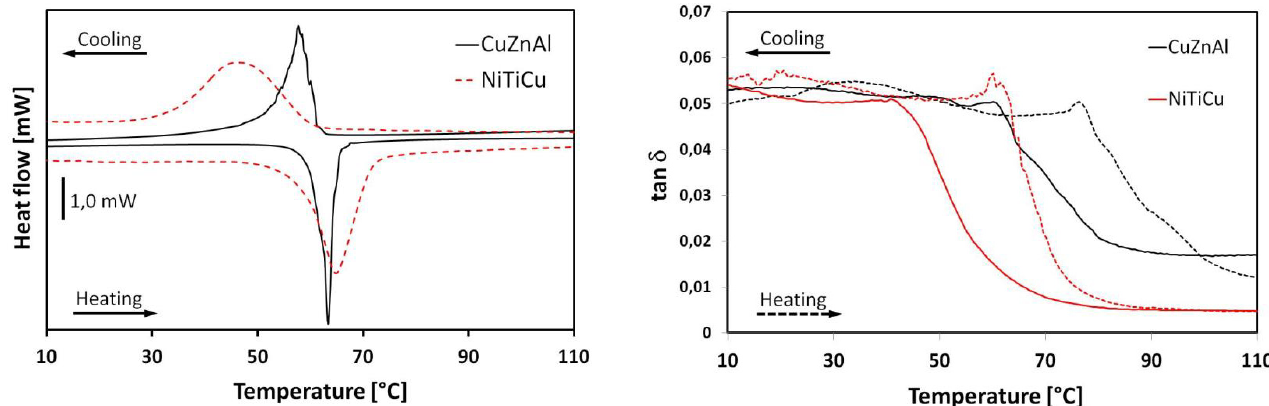
Figure 5: tan δ vs. temperature. DMA analysis: heating rate 1°C/min, frequency 10 Hz, strain amplitude